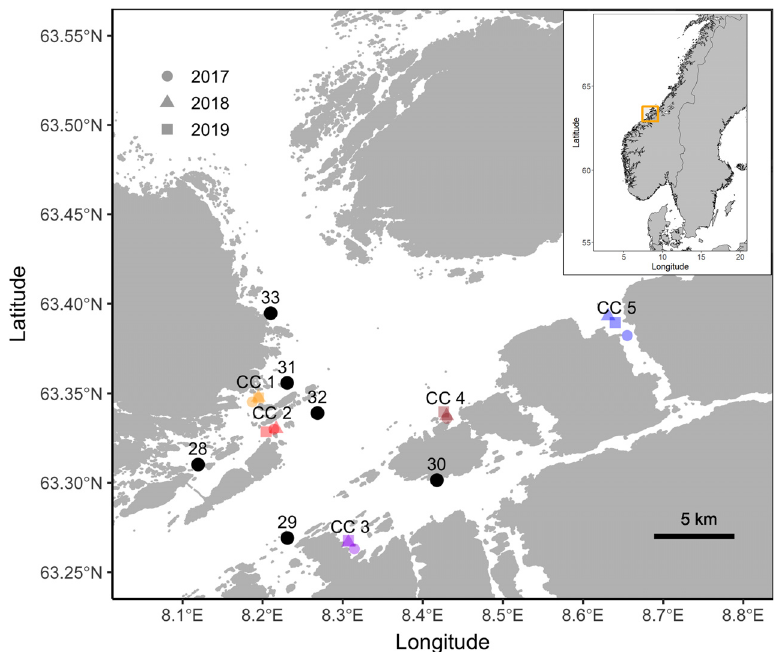
Fig. 1. Study area on the Norwegian coast (orange box in inset), positions of the salmon farms (black circles; numbers are station numbers given to the farms in the study) and yearly release positions of cod in the 5 respective catch clusters (CC): CC1: Glasøysvaet; CC2: Lauvøysvaet; CC3: Araneset;